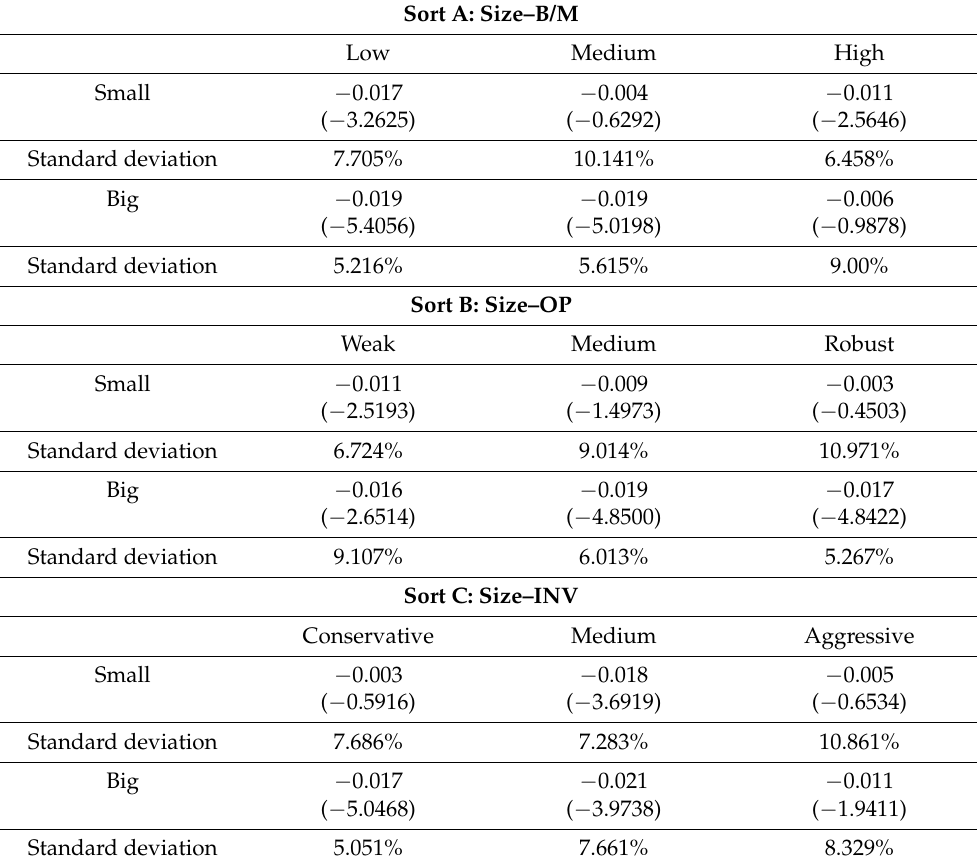
Table 3. Monthly excess return values for LHS